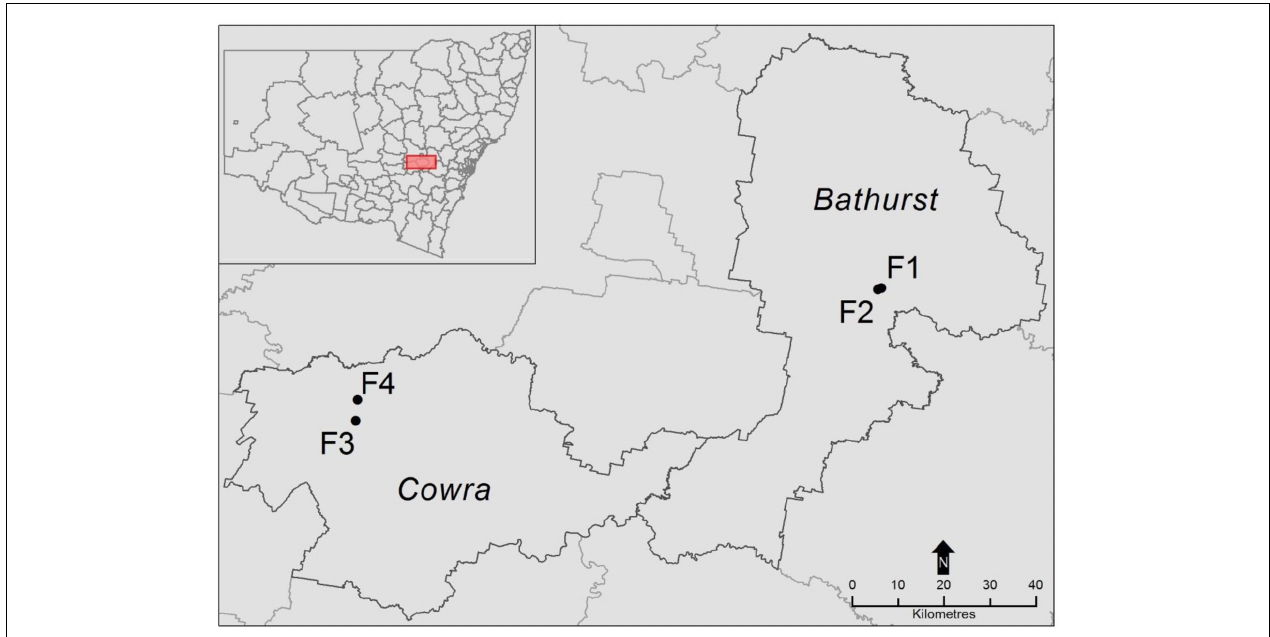
FIGURE 1 | Map of research sites in central west region of NSW,